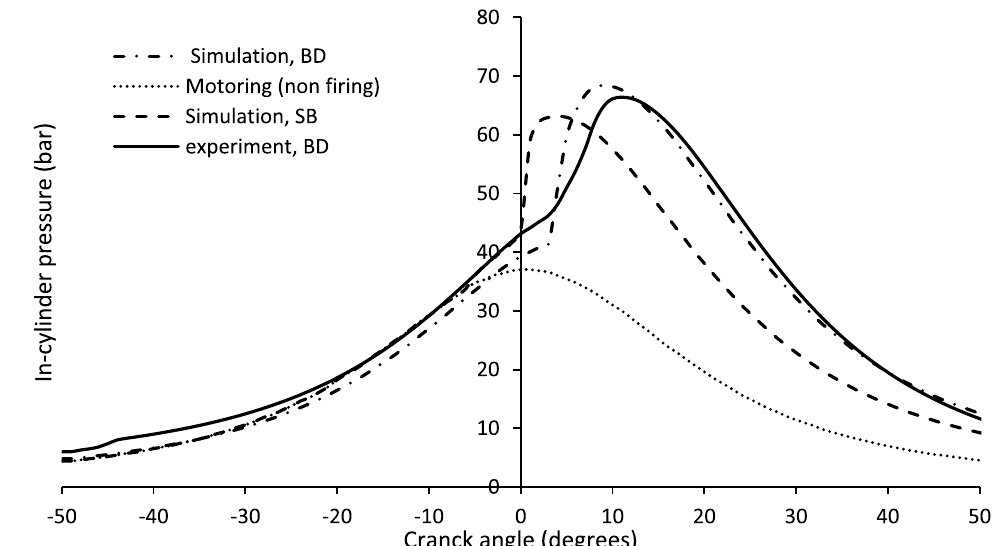
Fig. 7 In‑cylinder pressure for base diesel (BD) and soybean biodiesel (SB) fuels at 100% of engine rated load